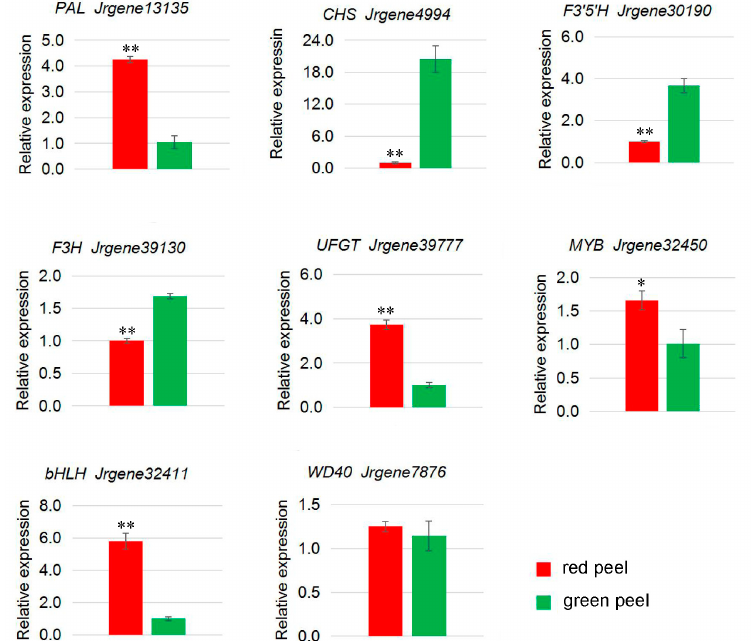
Figure 5. Expression analysis of eight candidate differentially expressed genes related to anthocyanin biosynthesis in the peel of red and green walnut at the fruit ripening stage by qRT-PCR. Relative transcript levels were calculated by the ddCt method with Actin as the standard. * p < 0.05, ** p < 0.01.